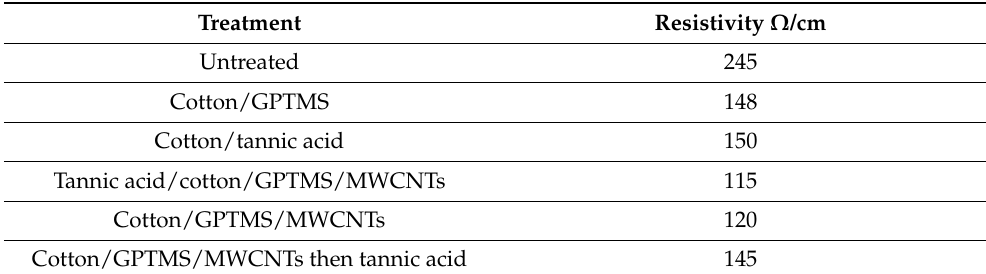
Table 3. Electrical properties of untreated and treated cotton